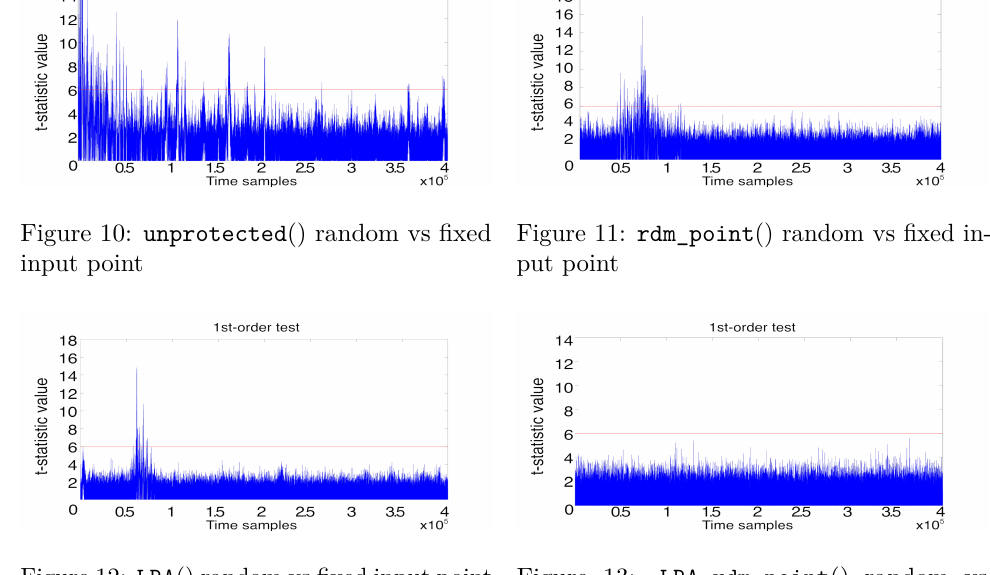
Figure 12: LRA () random vs fixed input point Figure 13: LRA_rdm_point () random vs fixed input